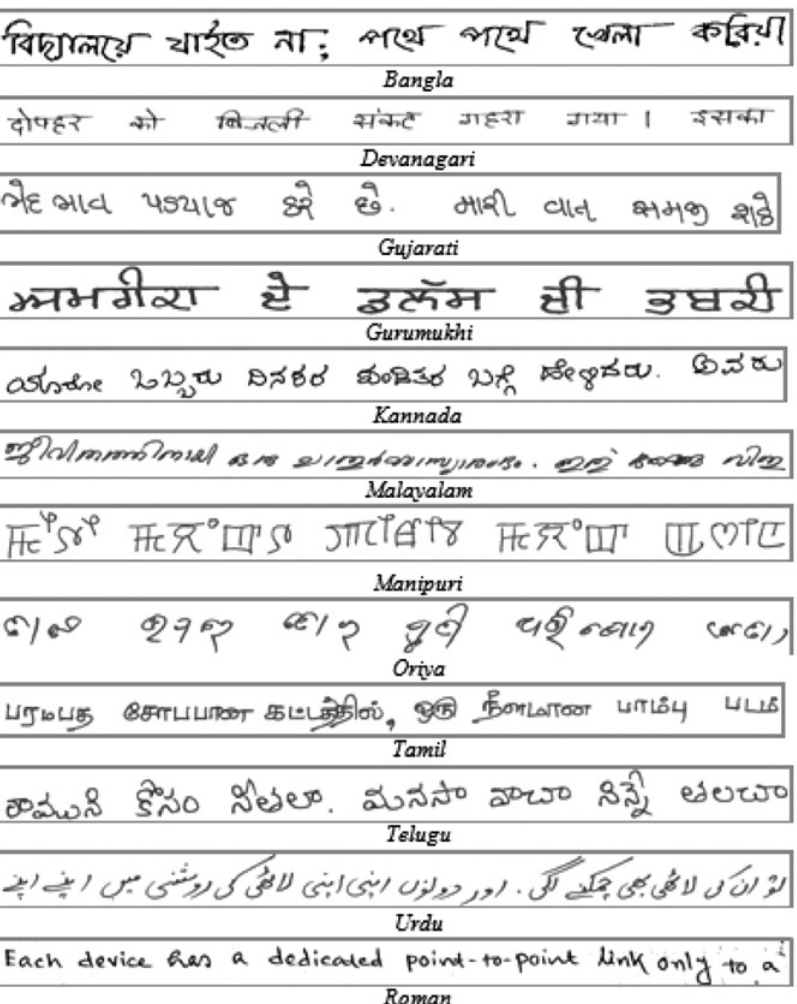
Figure 6: Sample Handwritten Text-Line Images Written in 12 Different Indic